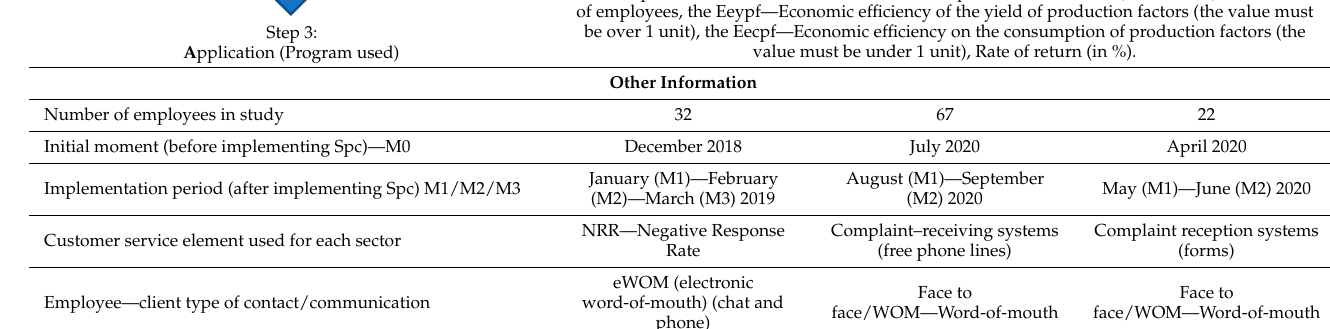
Table 2. Comparative table for describing Spc indicator variables and implementation methodology. Symbol from Spc